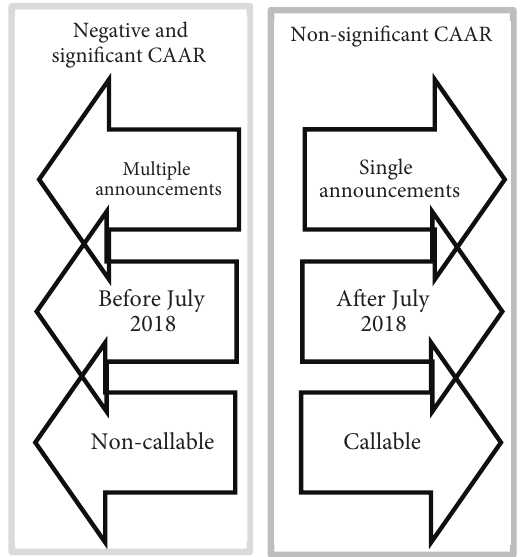
Figure 1. Event study results